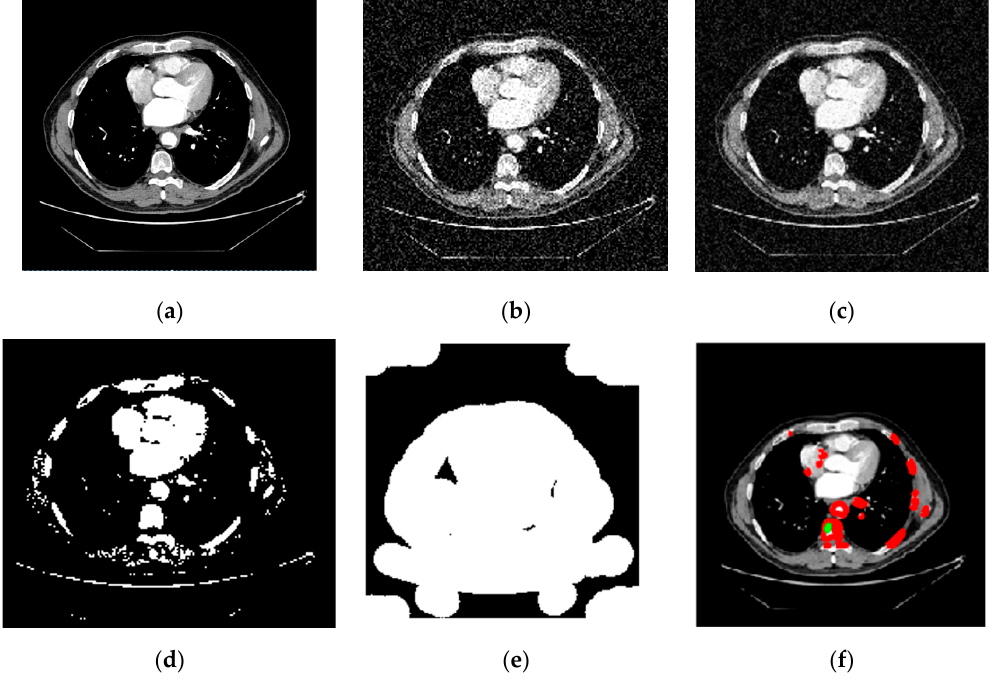
Figure 9. CT Image classification procedure. ( a ) Original Image. ( b ) Noisy Image. ( c ) Adaptive Filtering PSNR. ( d ) Dilate image. ( e ) Watershed Transform. ( f ) Lung cancer type: malignant.